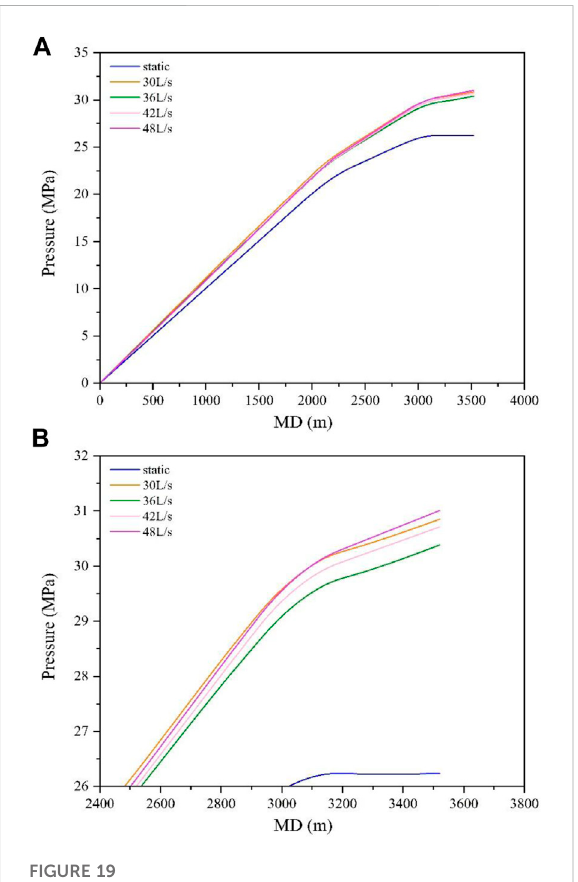
FIGURE 19 (A) Wellborepressurepro fi le. (B) Wellborepressurepro fi lefor the near-bottom